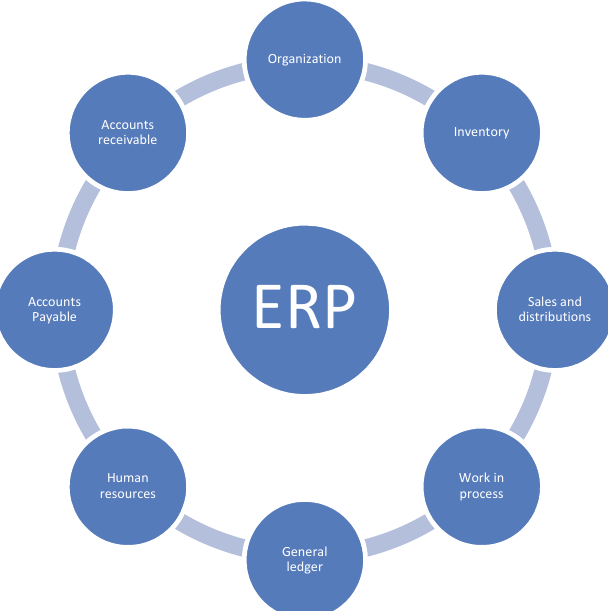
Fig. 1. Different components of